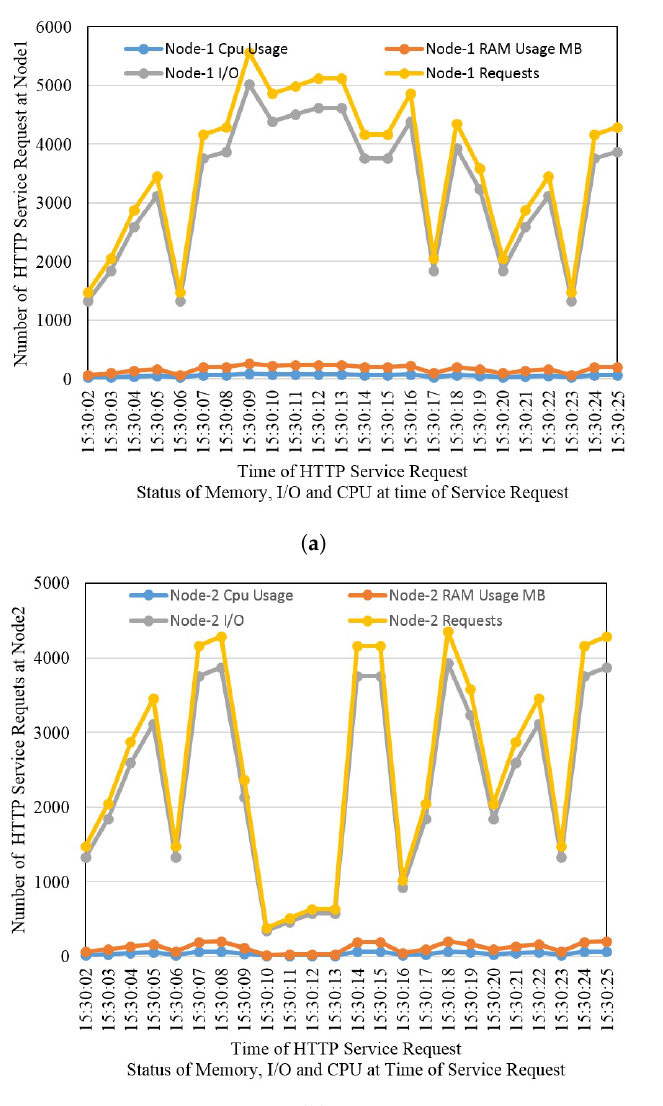
Figure 11. CPU, memory, and IO utilization at ( a ) Fog node 1 and ( b ) Fog node